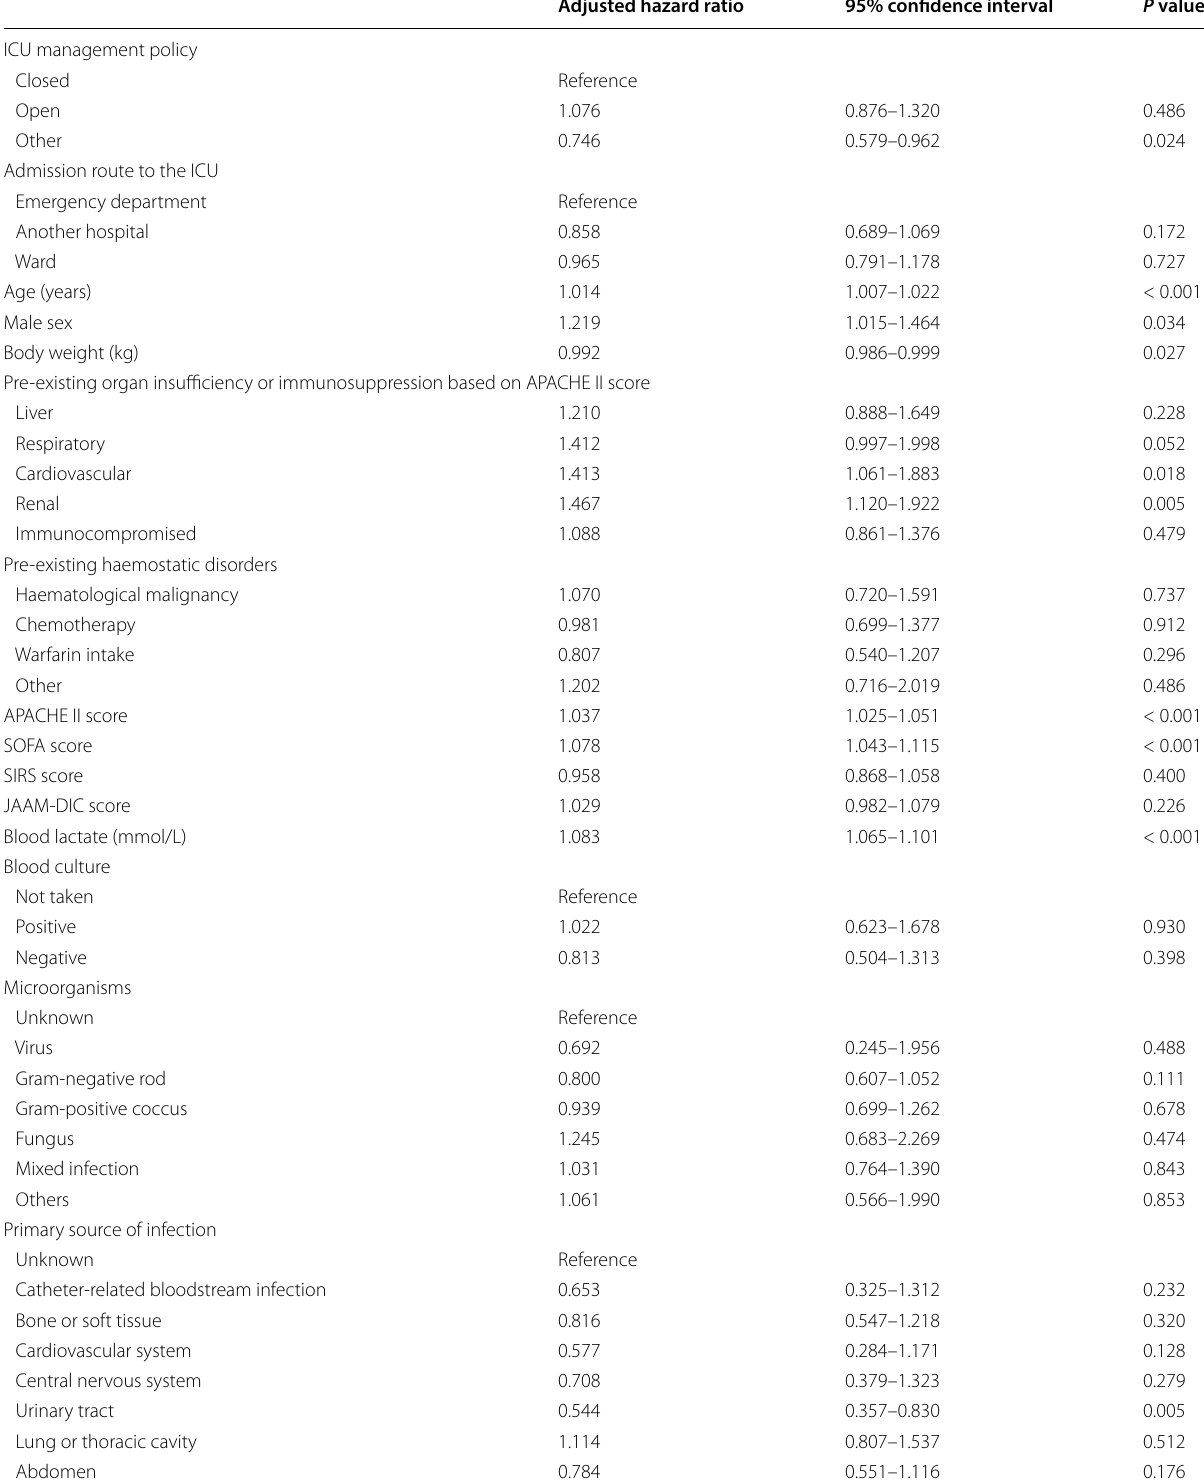
Table 4 Cox regression model adjusted for patient characteristics and therapeutic variables to assess hospital mortality in patients who received